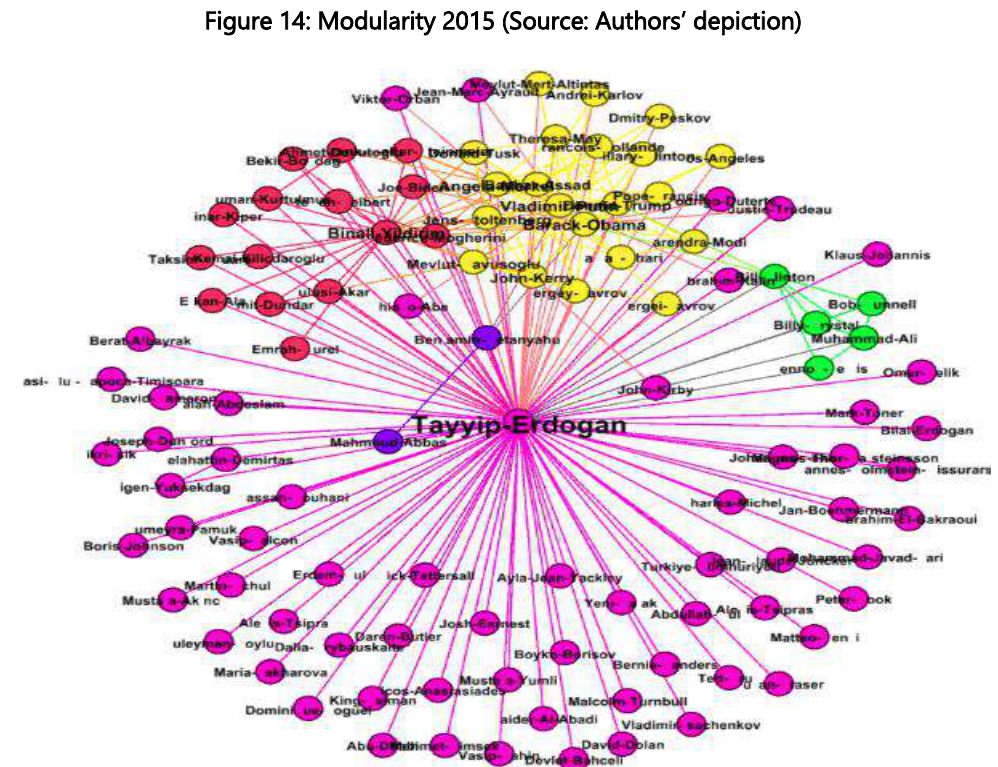
Figure 15: Modularity 2016 (Source: Authors ‟